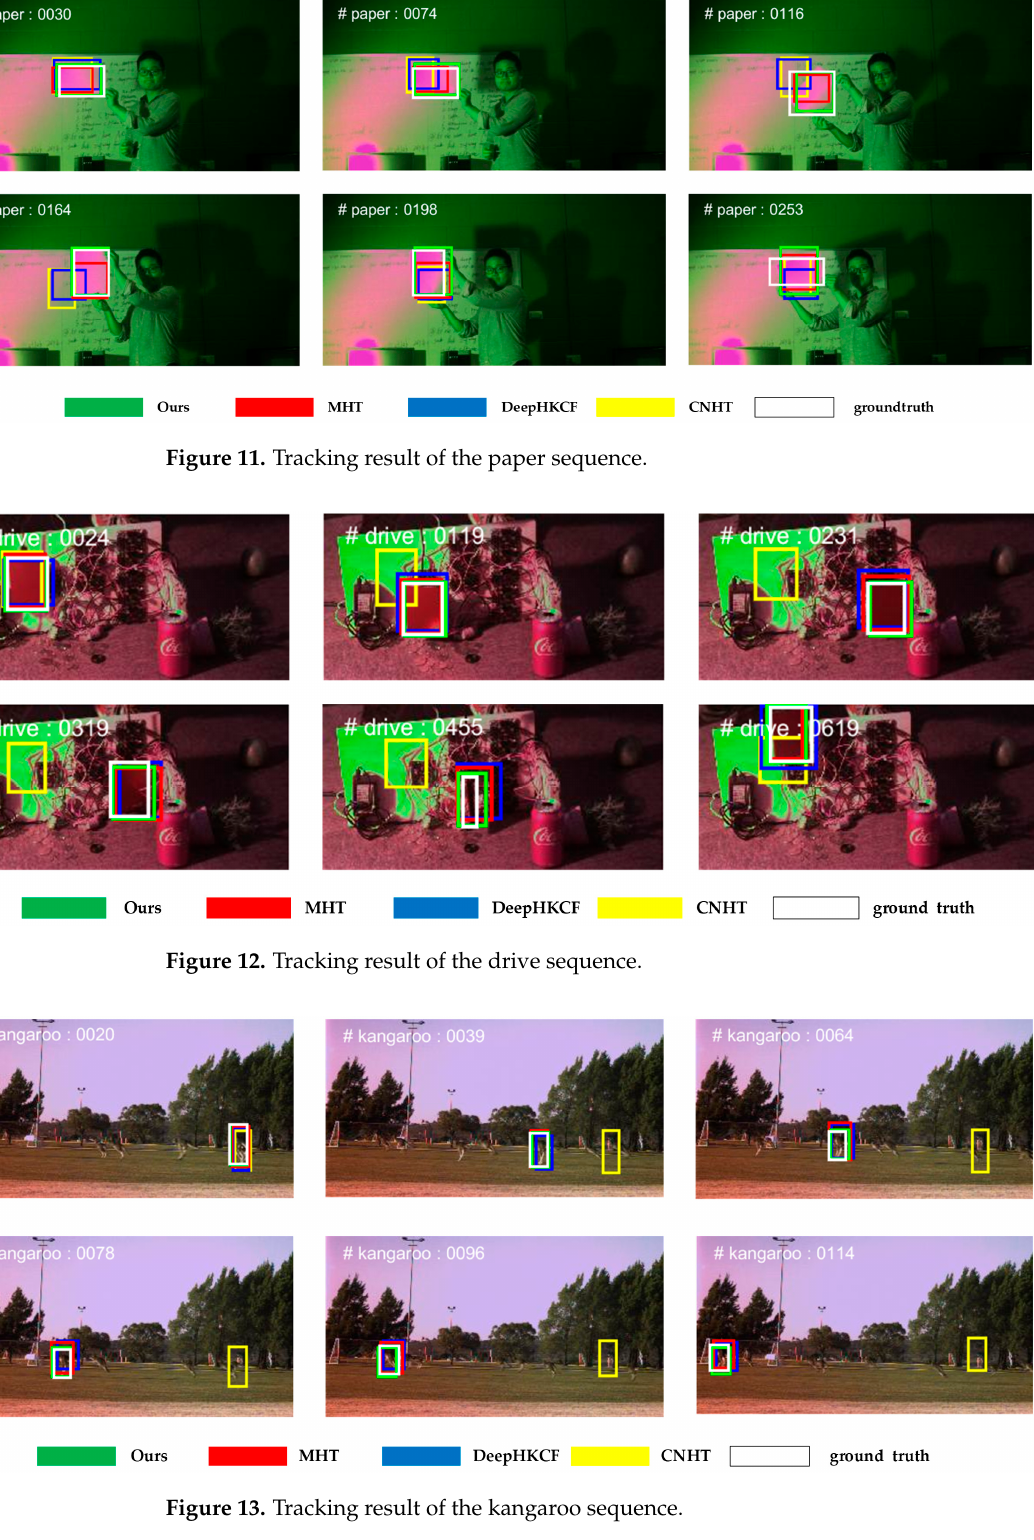
Figure 11. Tracking result of the paper sequence.